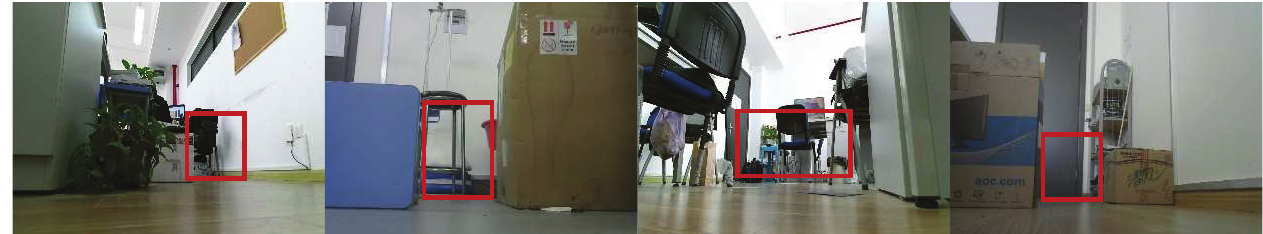
Figure 15. Indoor scene sample of path planning and forward direction